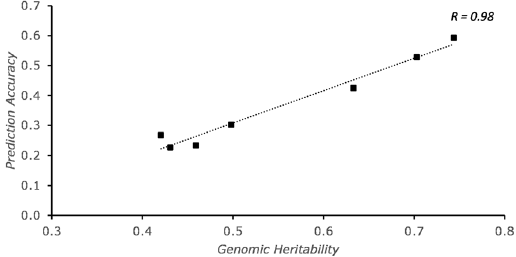
Figure 3. Correlation between prediction accuracy and genomic heritability for all traits.